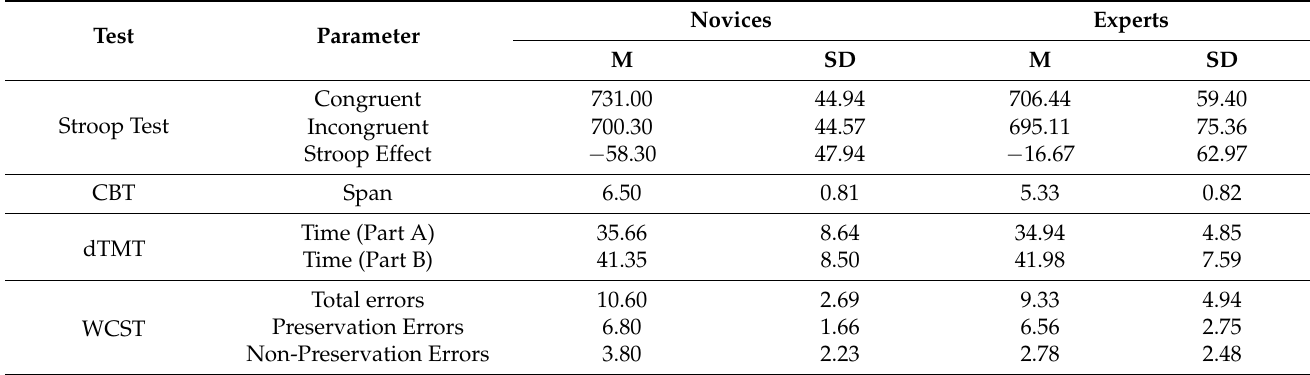
Table 2. Test values for the tests for executive functioning of the two groups (novices; experts). Group differences measured with Mann–Whitney U